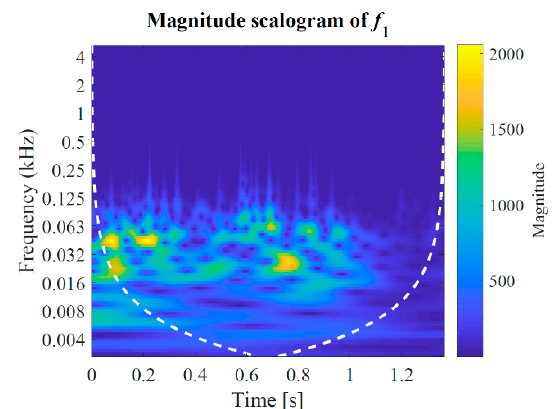
Figure 5. CWT (continuous wavelet transform) of the CWT coefficients at f 1 = 230 Hz.